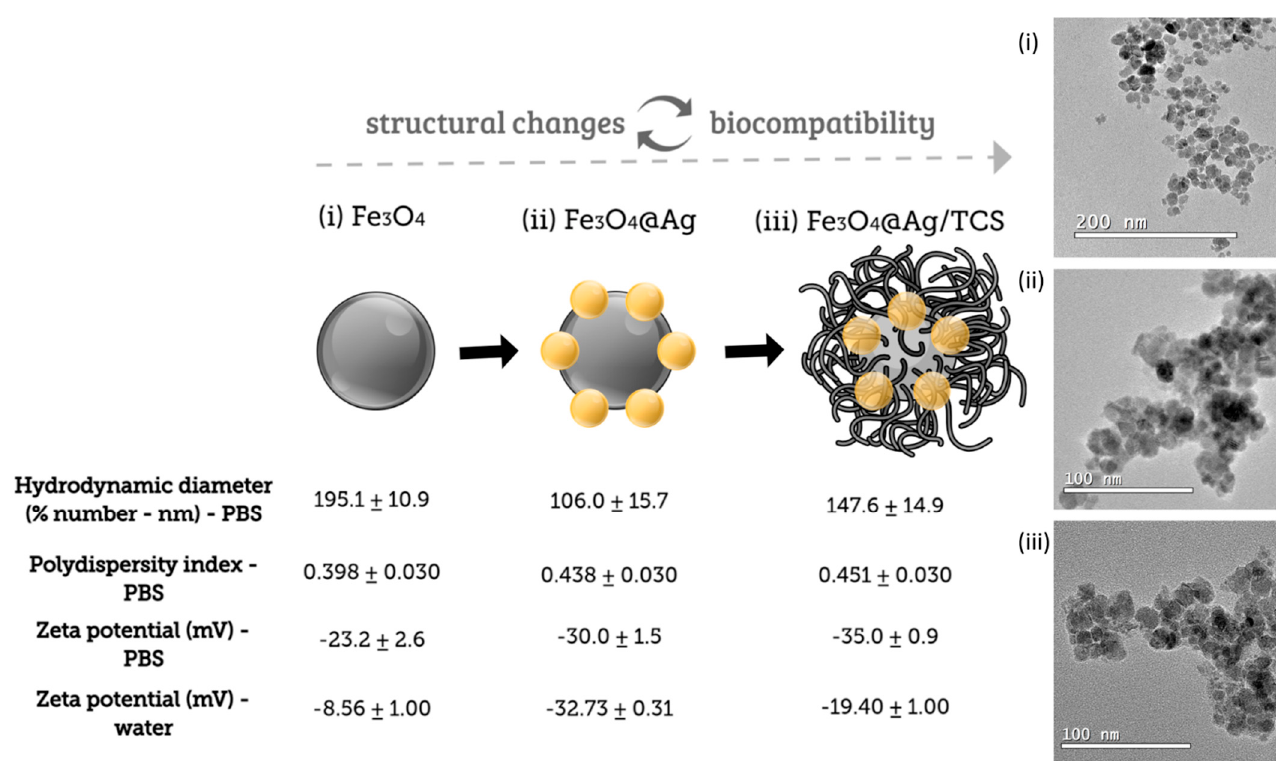
Figure 1. Schematic representation of the NPs evaluated in this work, and values of hydrodynamic diameter expressed by percentage of number; PDI (in PBS medium) and zeta potential values for Fe 3 O 4 NPs, Fe 3 O 4 @Ag NPs, and Fe 3 O 4 @Ag/TCS NPs in water and in PBS. TEM micrographs of (i) Fe 3 O 4 NPs, (ii) Fe 3 O 4 @Ag NPs, and (iii) Fe 3 O 4 @Ag/TCS NPs showing, respectively, average solid-state diameters of 14.4 nm ± 5.0, 13.6 nm ± 2.5, and 14.6 nm ± 1.5.